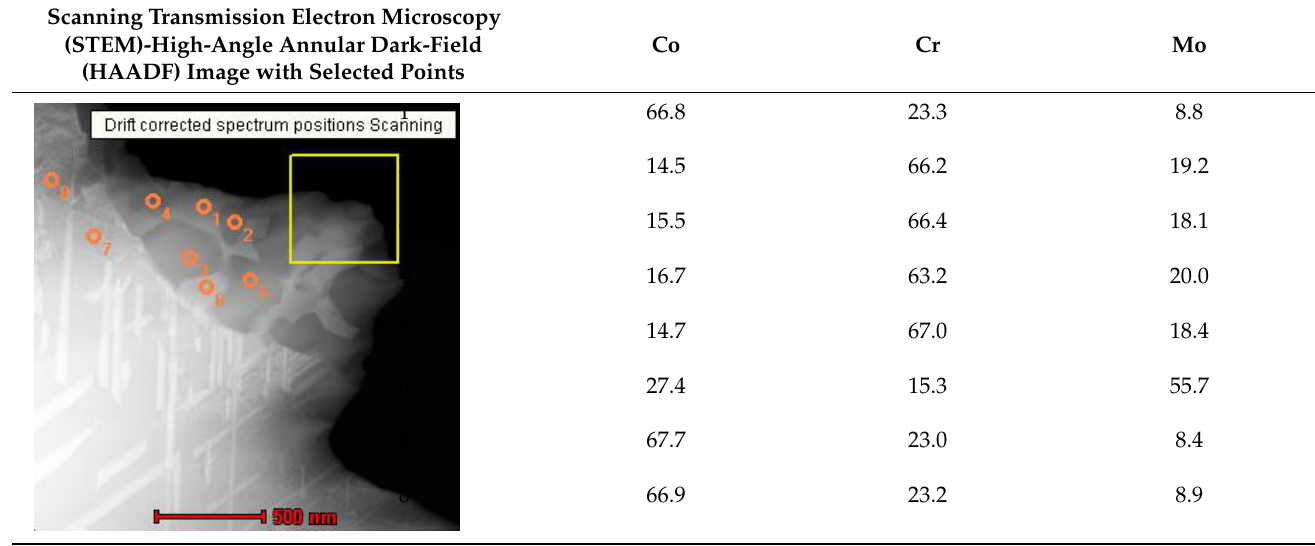
Figure 5. TEM observations of the initial microstructure of the cast Co-Cr-Mo alloy: ( a ) fcc matrix with hcp needles; ( b ) diffraction pattern for image ( a ); ( c ) domain of carbidic precipitates; ( d ) M 23 C 6 carbide; ( e ) Laue diffraction patterns for image ( c ). Table 3. Point TEM-EDS analyses in selected areas of the carbidic domain (wt%). Scanning Transmission Electron Microscopy (STEM)-High-Angle Annular Dark-Field (HAADF) Image with Selected Points